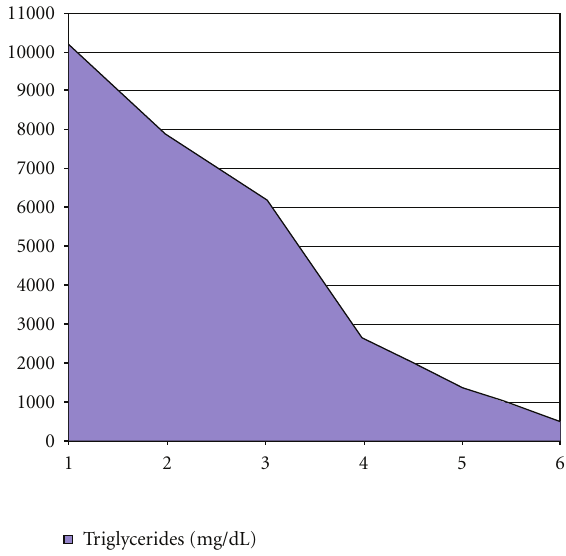
Figure 3: Serum triglycerides levels during the first six hospitaliza- tion